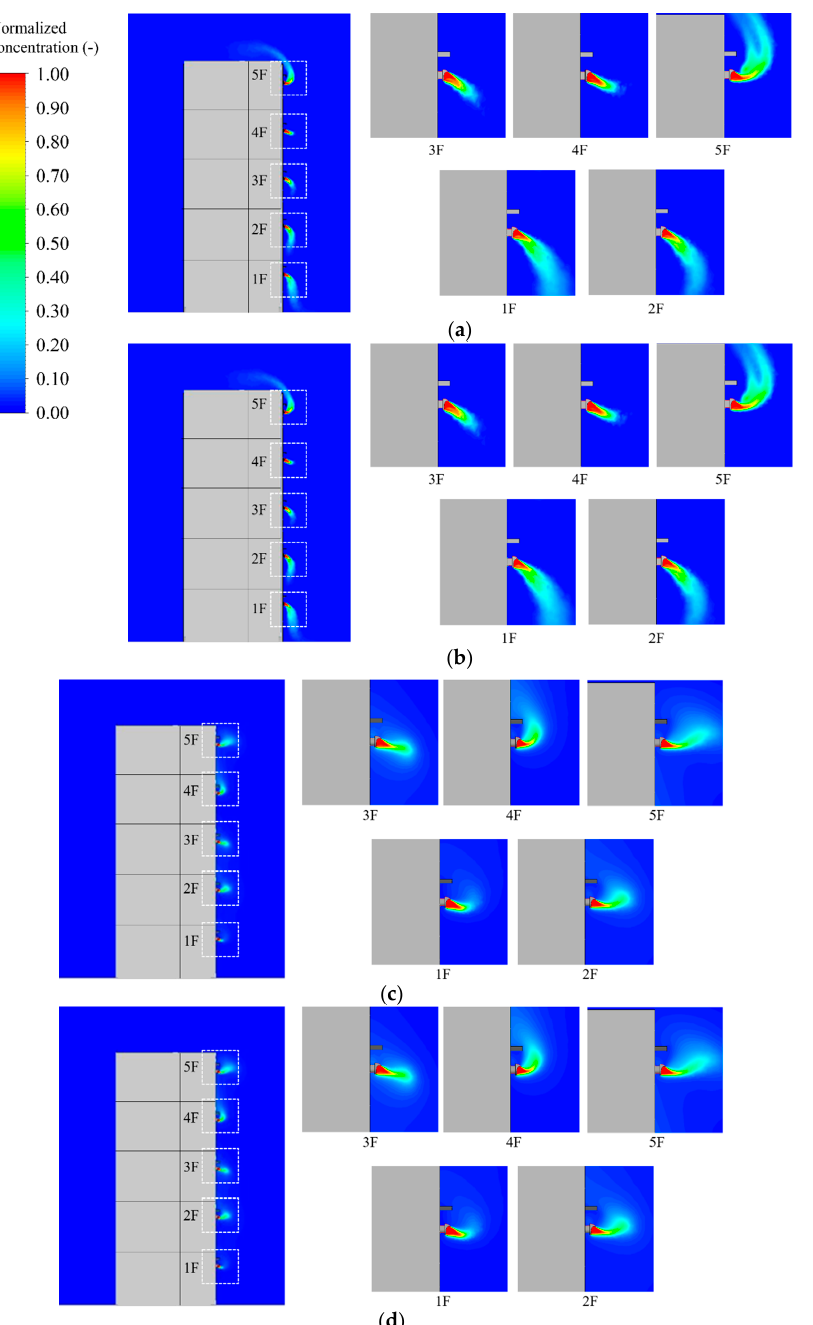
Figure 8. Normalized concentration distribution of exhaust air (Section-ABCD): ( a ) Case 1; ( b ) Case 4; ( c ) Case 7; ( d ) Case 10.